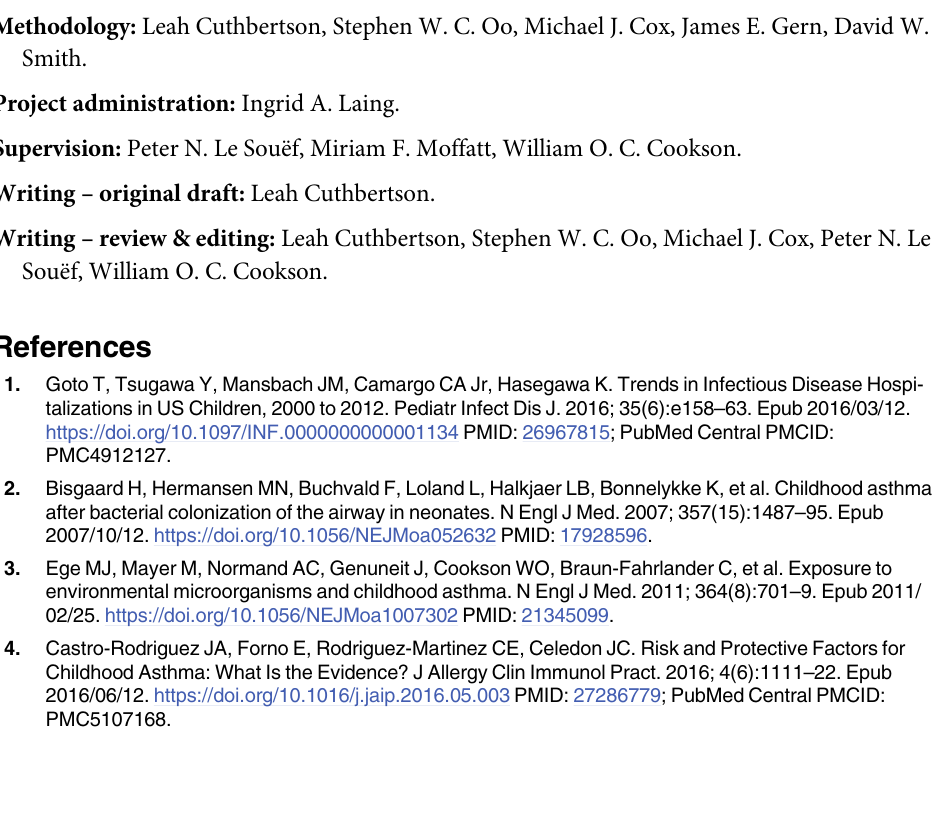
S2 Fig. Volcano plot showing differential abundance of OTUs based on results from DeSeq2 analysis. OTUs considered statistically significant (p-value < 0.001) were coloured based on genus level identification. S3 Fig. Stacked bar plot comparing OP samples from children with bronchiolitis and acute wheeze to healthy controls. Hierarchical clustering based on Bray-Curtis dissimilarity was used to order stacked bar plots for individuals. Adonis permutational ANOVA revealed bron- chiolitis explained 9.8% of the variation. S4 Fig. Boxplots showing diversity measures associated with recurrence data from acute wheeze